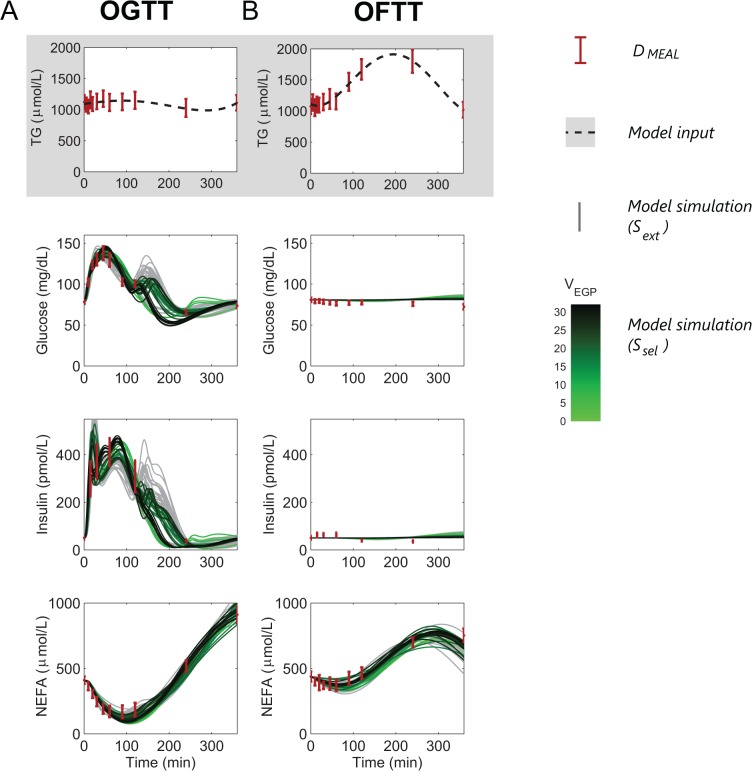
Model calibration on meal responses.Data from DMEAL
[48] (red errorbars) and model simulations (Sext, grey curves; and Ssel, green shading as in Fig 4) in response to an OGTT (A) and an OFTT (B).